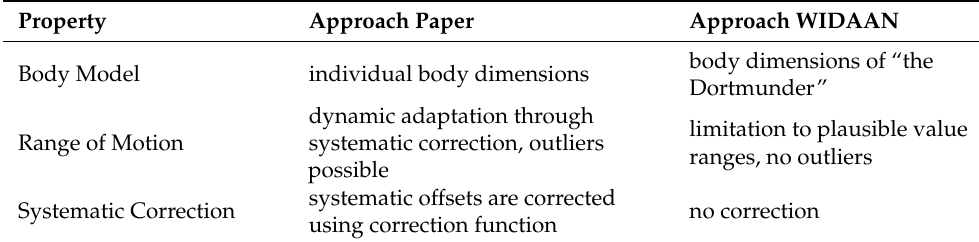
Table 3. Differences between the approach used in this paper and WIDAAN.